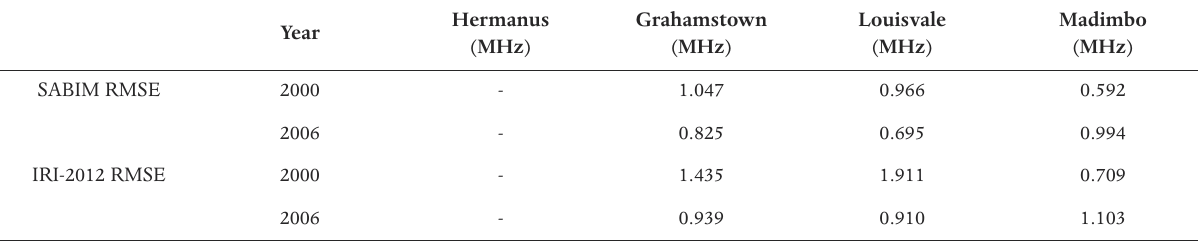
Table 3. RMSE for the SABIM and IRI-2012 model for the years 2000 (solar maximum) and 2006 (solar